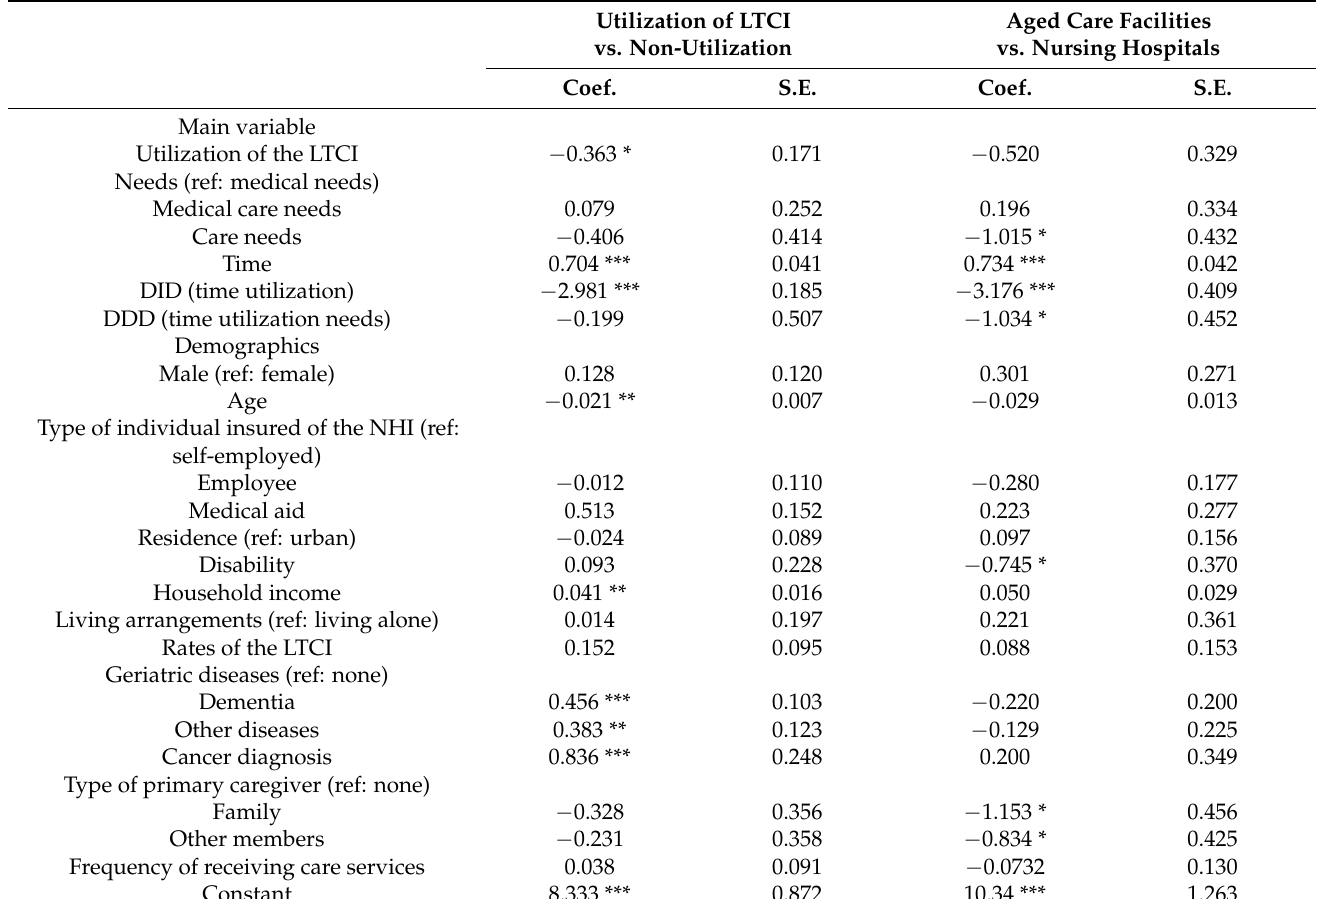
Table 2. Panel regression